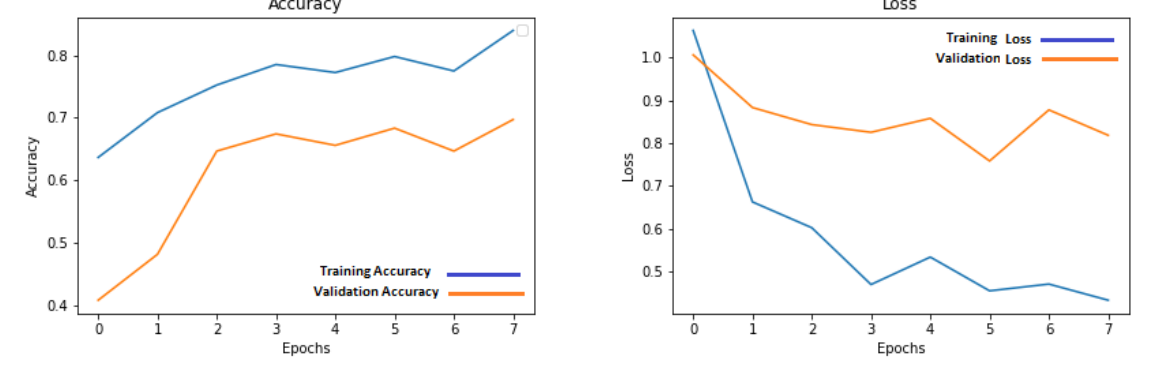
Figure 9. Accuracy and loss graphs for training and validation on low-resolution images.